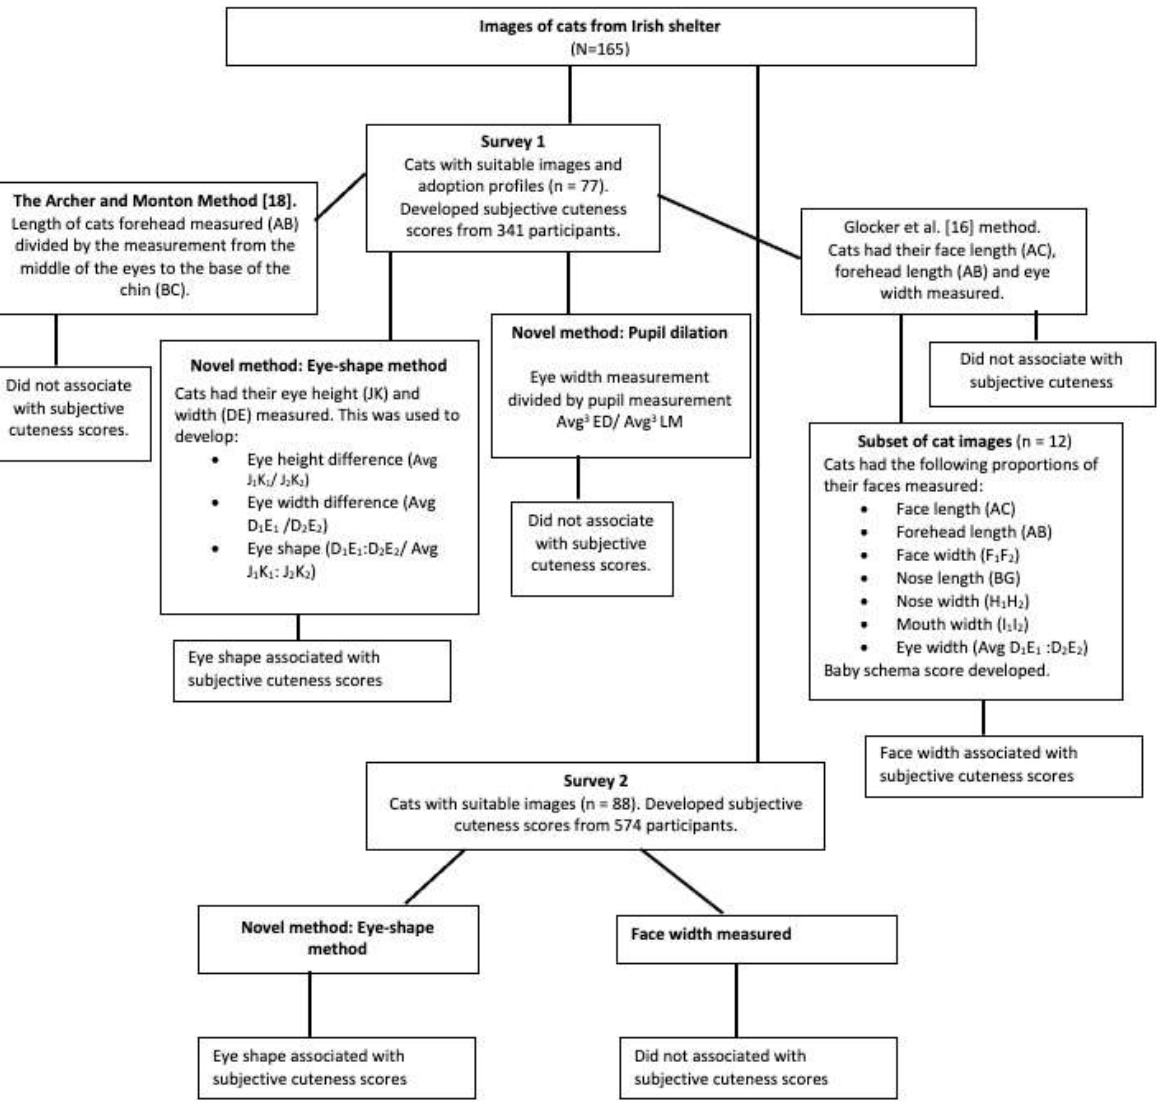
Figure 1. The path diagram gives an overview of the procedure followed during the development the objective cuteness of the objective cuteness measures.